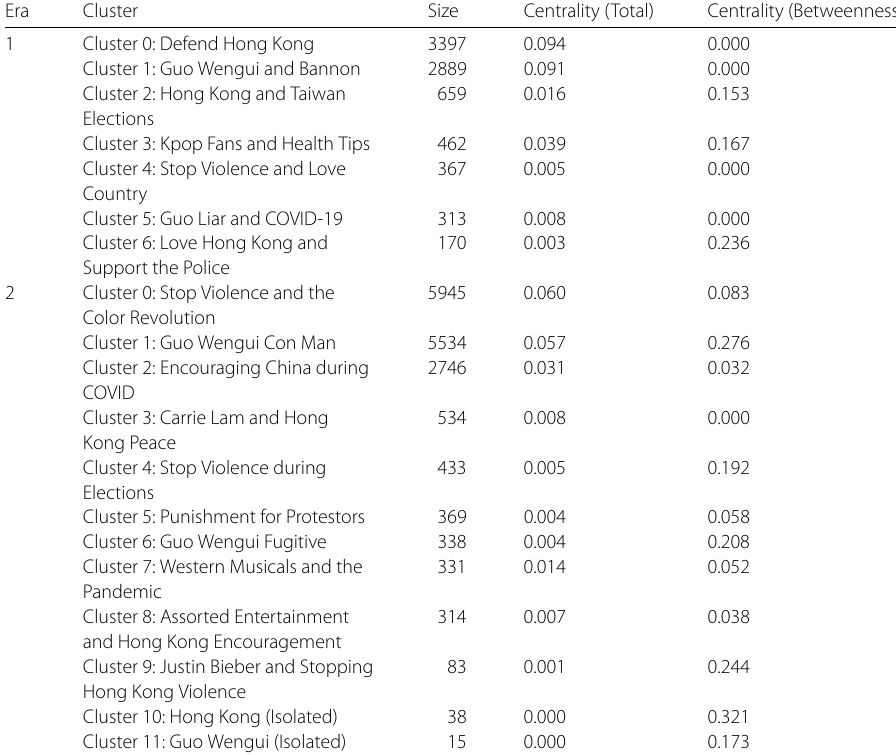
Table 5 Descriptive statistics of derived MVMC clusters. Centralities are calculated on the cluster by cluster networks per time period